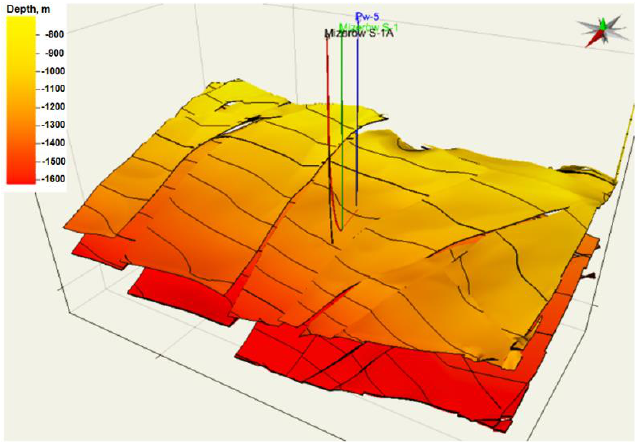
Figure 2. Coal seams 405 and 510 as reflected in the model.